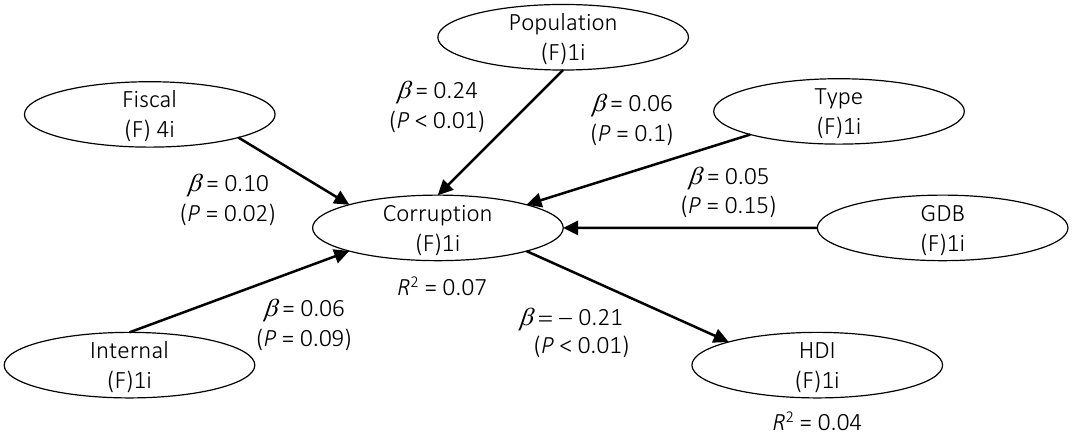
Figure 1. Results of Partial Least Square (PLS)